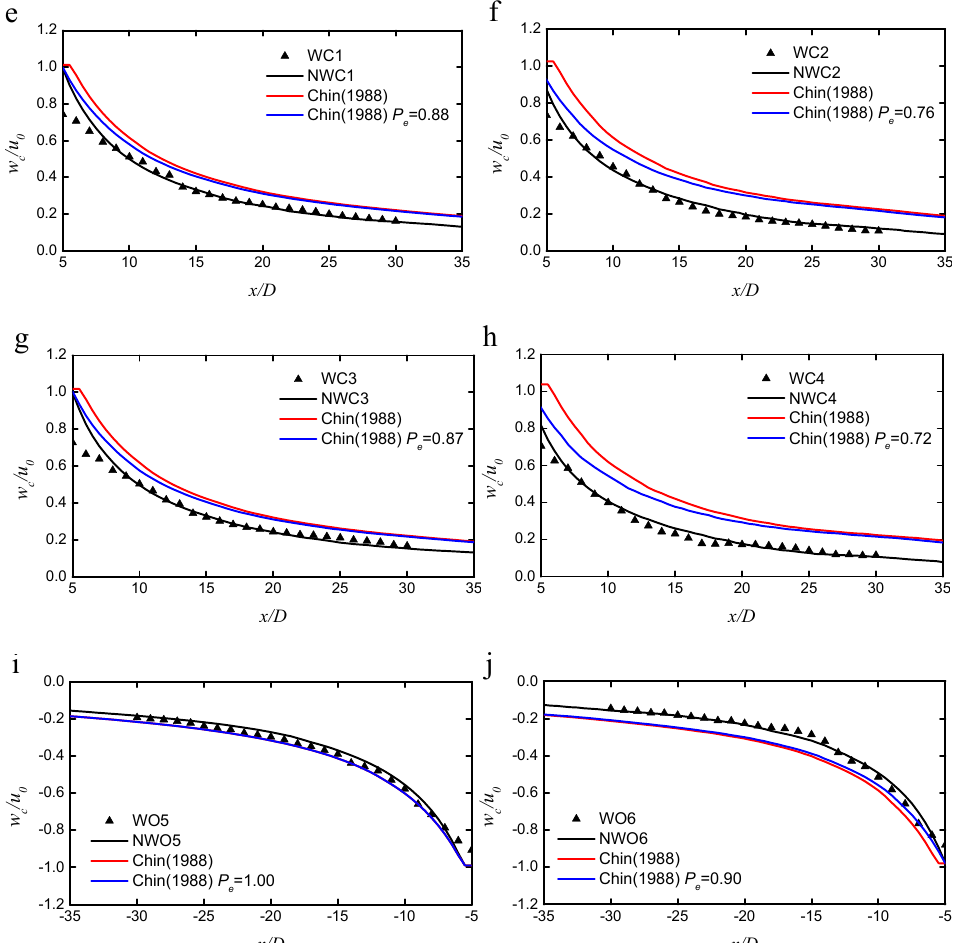
Figure 7. Comparison of jet axial velocity along the centerline for the experimental cases of ( a ) VW7 & NVW7, ( b ) VW8 & NVW8, ( c ) VW9 & NVW9, ( d ) VW10 & NVW10, ( e ) WC1 & NWC1, ( f ) WC2 &